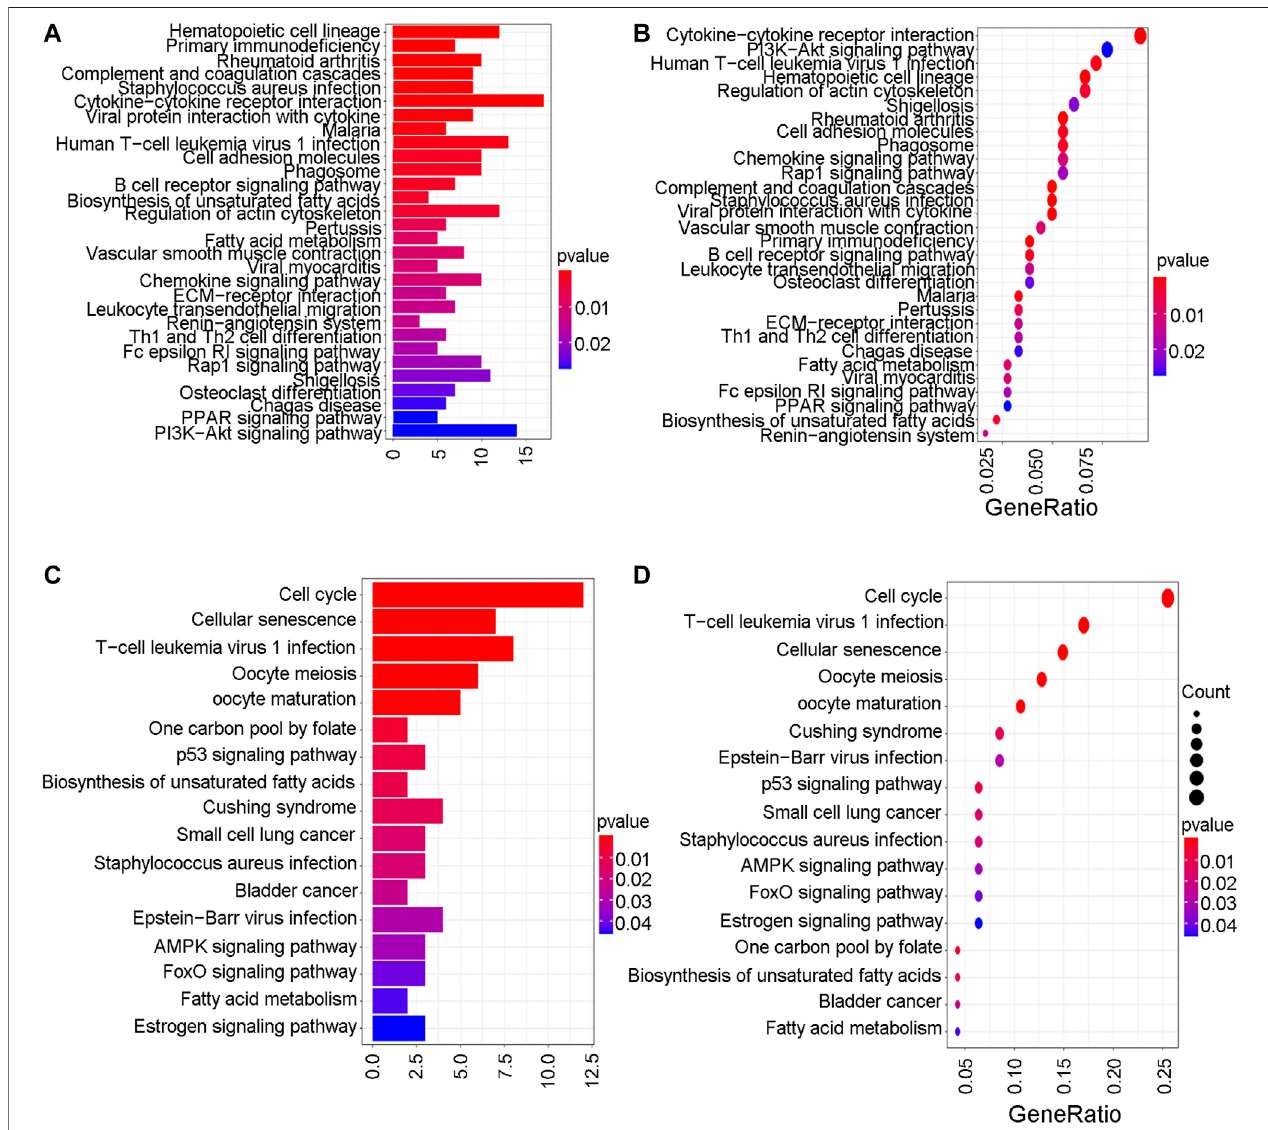
FIGURE11| KEGGanalysis. (A) TheKEGGanalysisbybarplotinTCGAcohort. (B) TheKEGGanalysisbybubblechartinTCGAcohort. (C) TheKEGGanalysisby barplot in GEO cohort. (D) The KEGG analysis by bubble chart in GEO cohort.